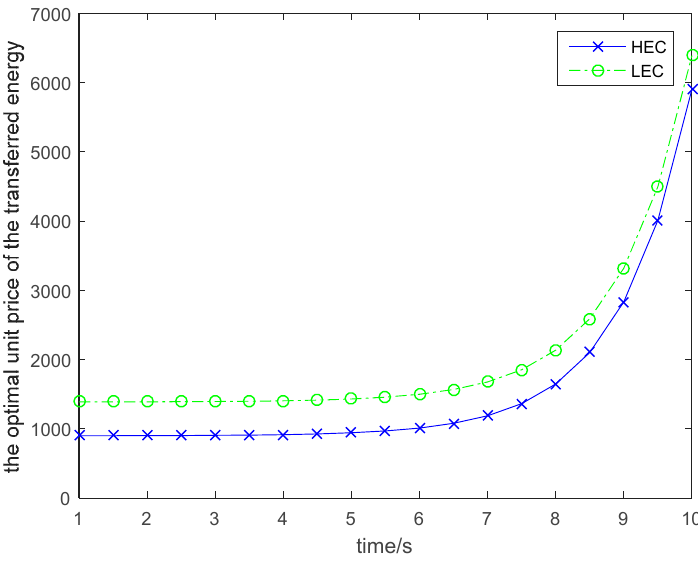
Figure 5. Optimal unit price of the transferred energy.